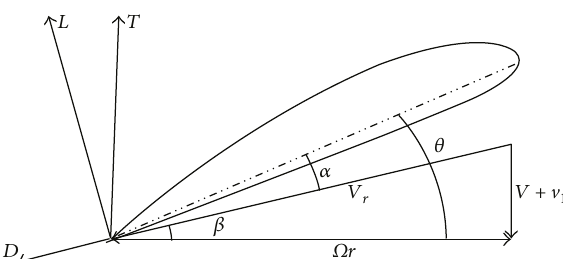
Figure 3: The blade cross-section showing simpli fi ed velocity triangle and aerodynamic forces.